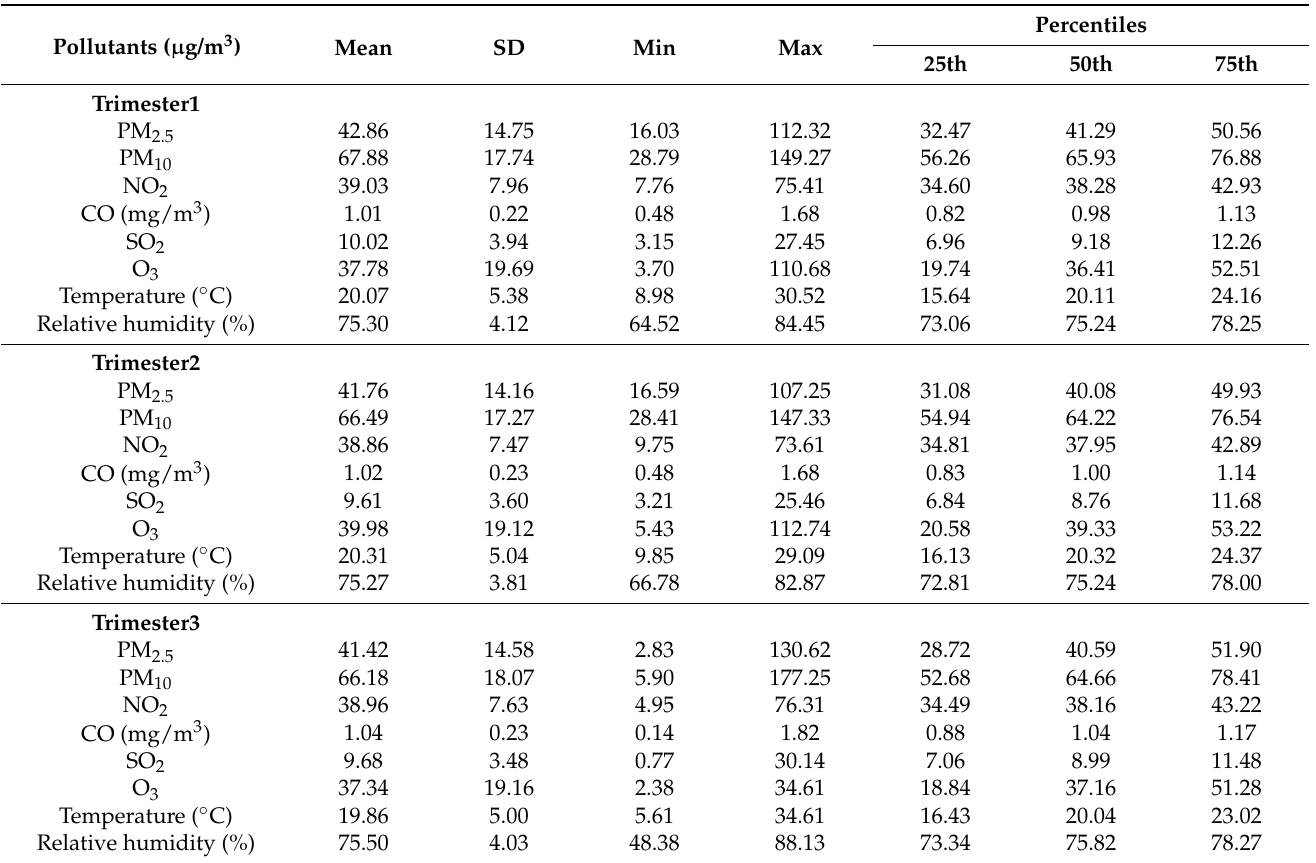
Table 2. The descriptive summary of air pollutants and meteorological factors in the study